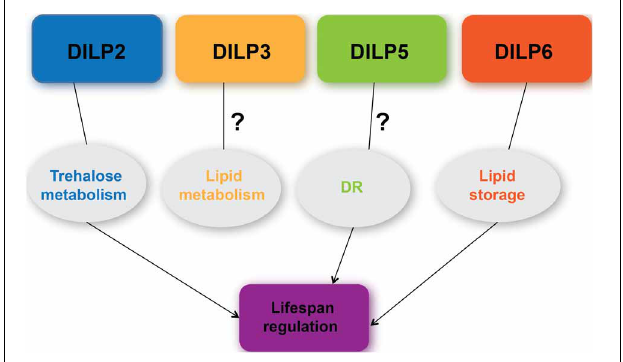
FIGURE 3 | A current understanding of the roles of DILPs 2, 3, 5, 6 in metabolism, DR response, and lifespan